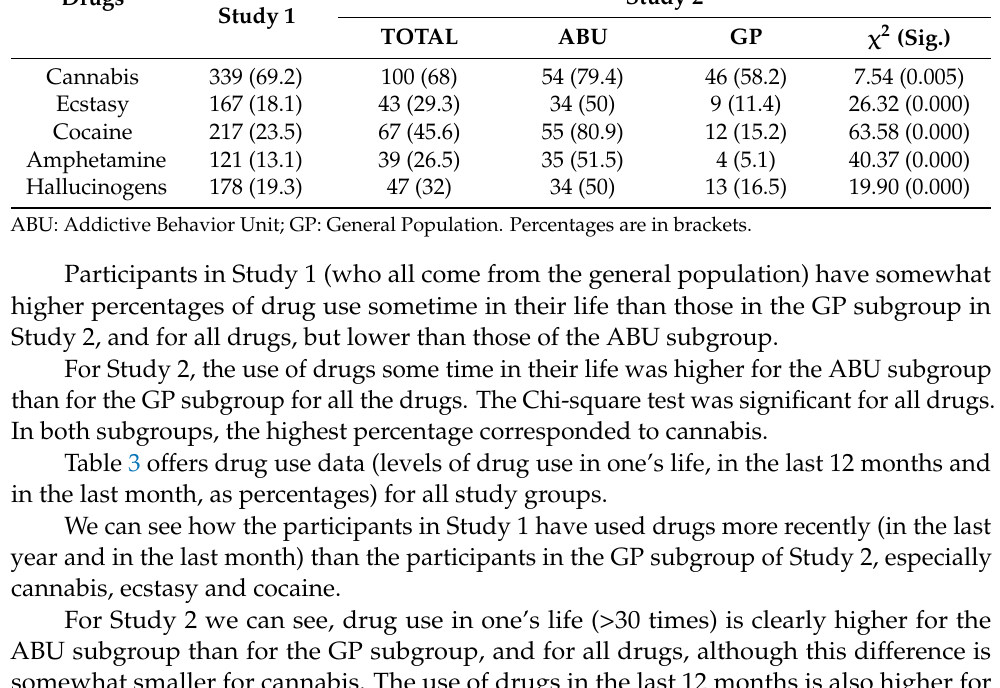
Sometime in Their Life Study 2